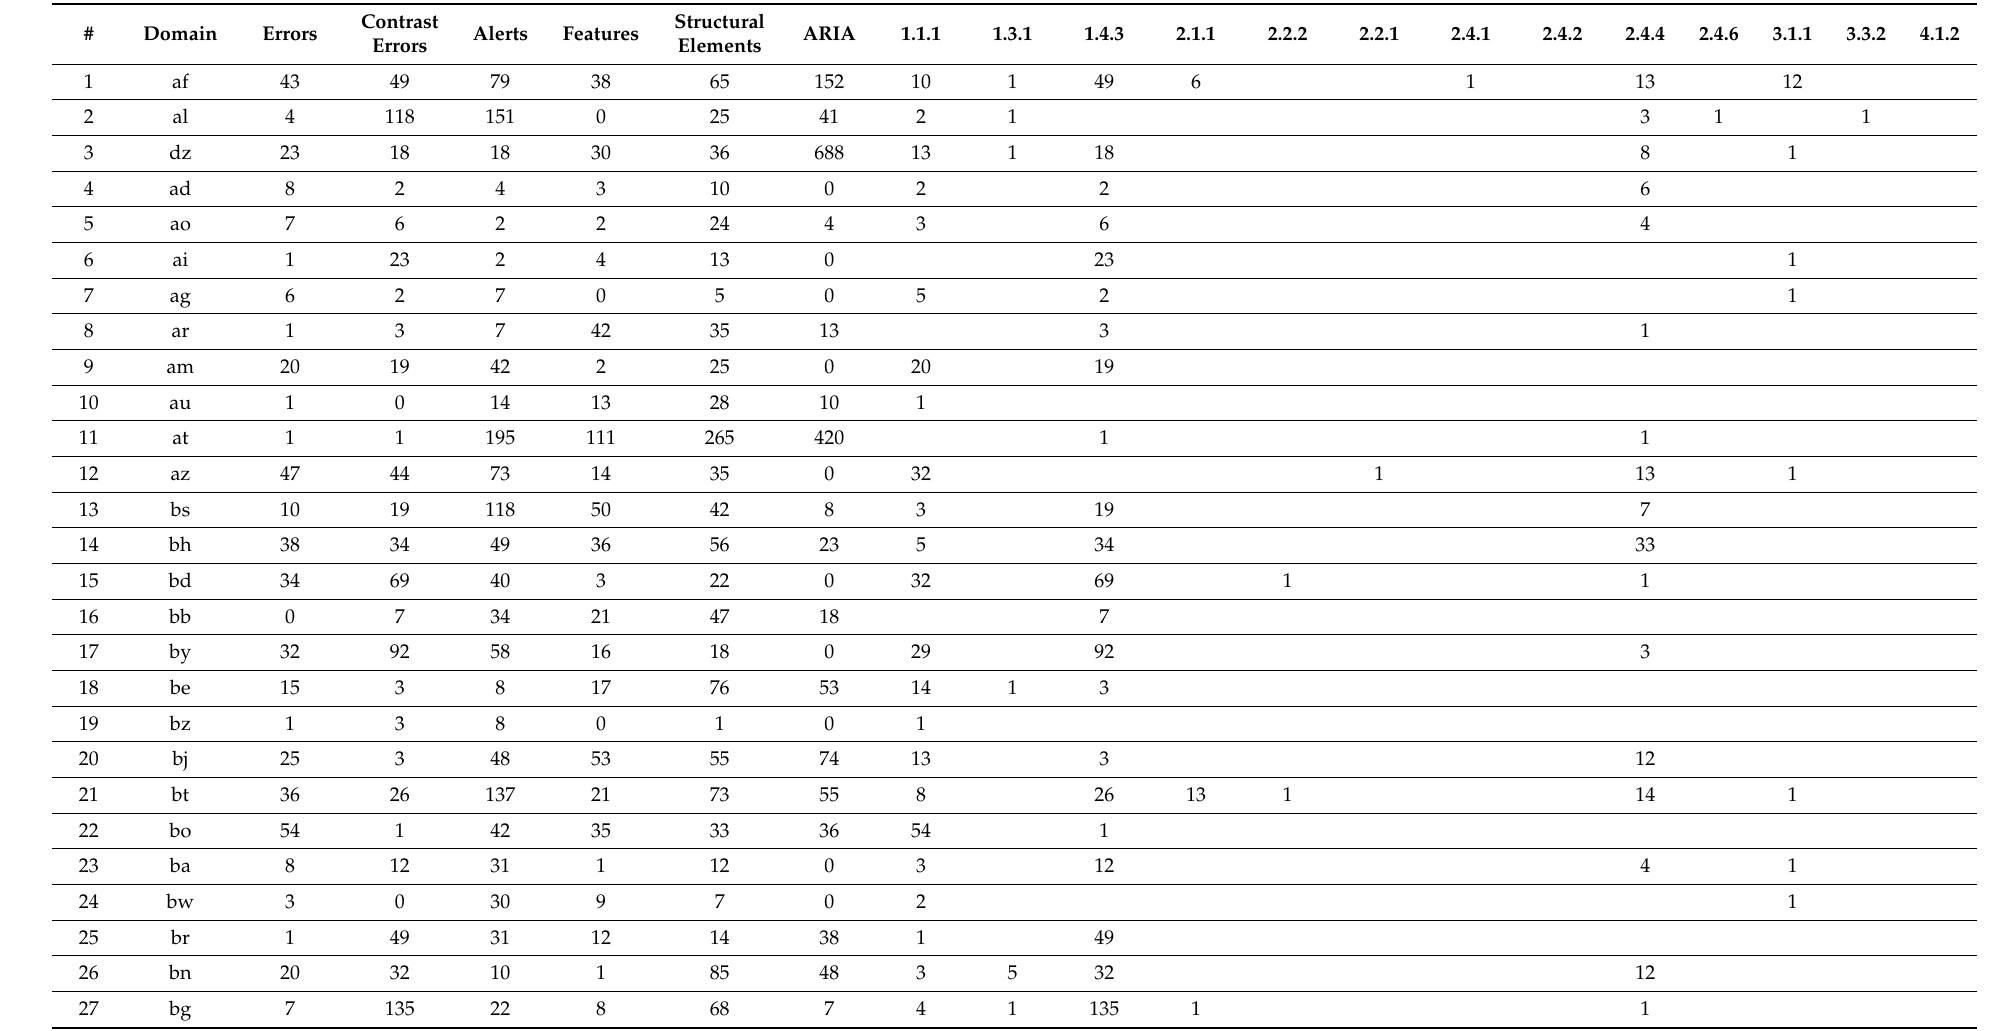
Table 4. Sample of the first 40 websites evaluated with